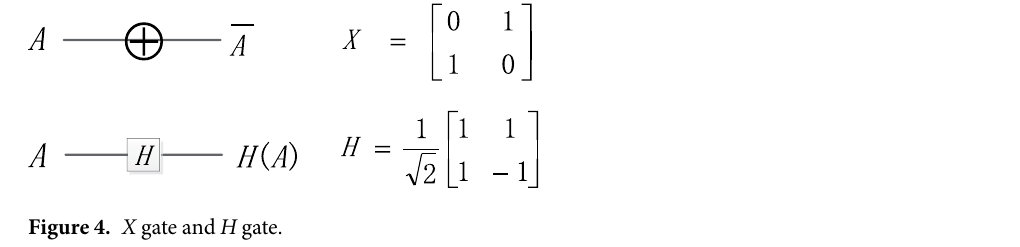
Figure 4. X gate and H